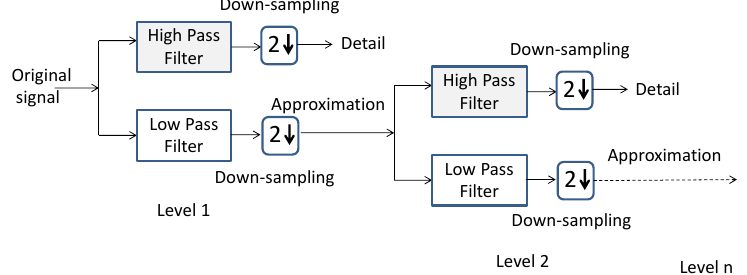
Figure 1. Schematic diagram showing the process of decomposition using the DWT